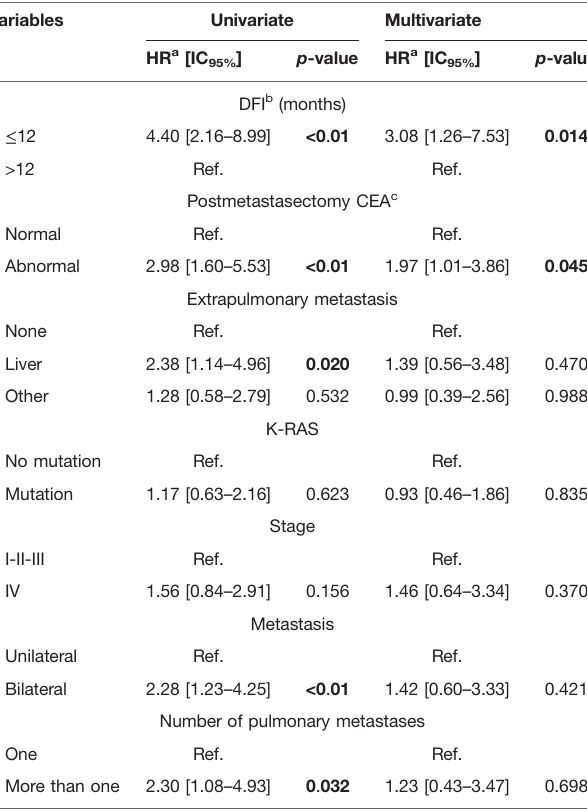
TABLE 4 | Univariate and multivariate analysis of overall survival. TABLE 3 | Associations between overall survival, disease-free survival and